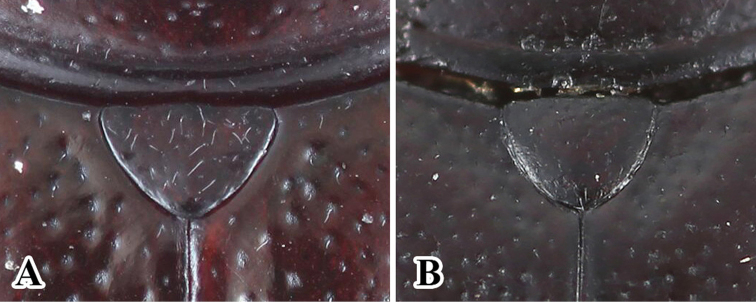
Scutellum. ASinocymbachus
bimaculatusBSinocymbachus
humerosus.